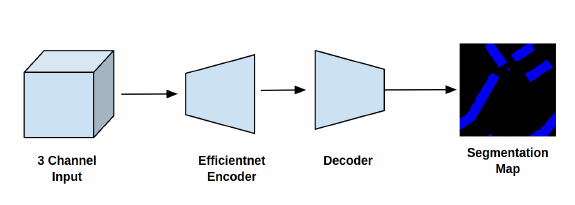
Figure 3. Single Stream Segmentation Network.